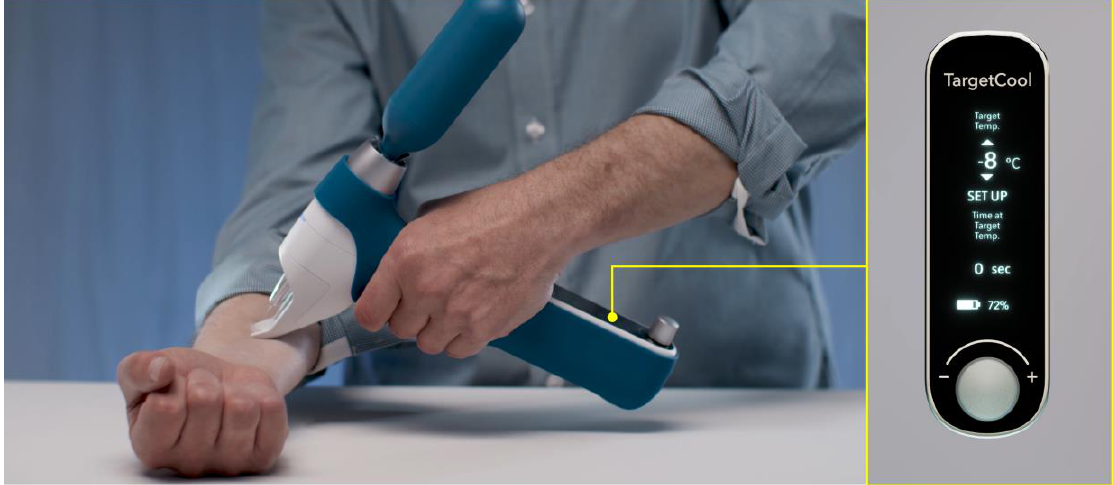
Figure 7. A novel cryotherapy device (TargetCool) developed to provide precise, controlled tissue cooling to reduce pain and inflammation of local procedures. This device uses pressurized carbon dioxide as a cryogen and can actively monitor and maintain the target temperature at a preset temperature (courtesy of RecensMedical, Ulsan, Korea).